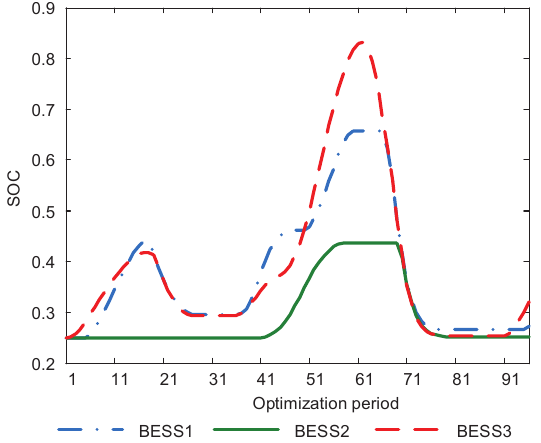
Figure 9. The state of charge (SOC) of BESSs in MGs on Day 1 of Scenario 1.